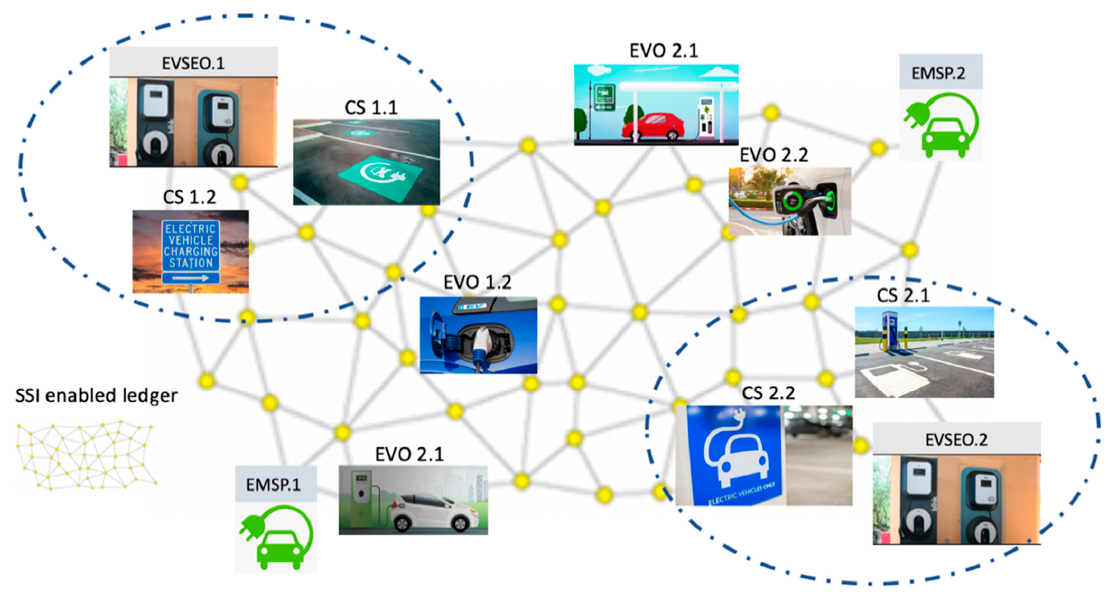
Figure 23. Our simulation scenario.